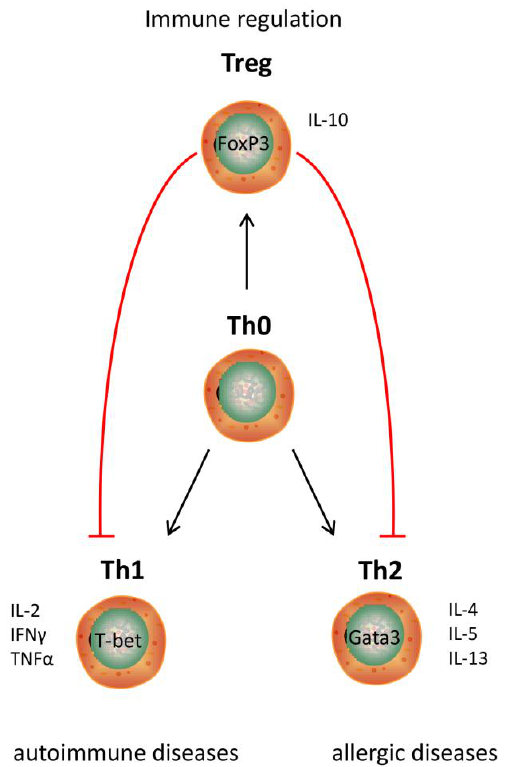
Figure 5. Overview of T helper cell subsets and their interactions and their relation to specific diseases.